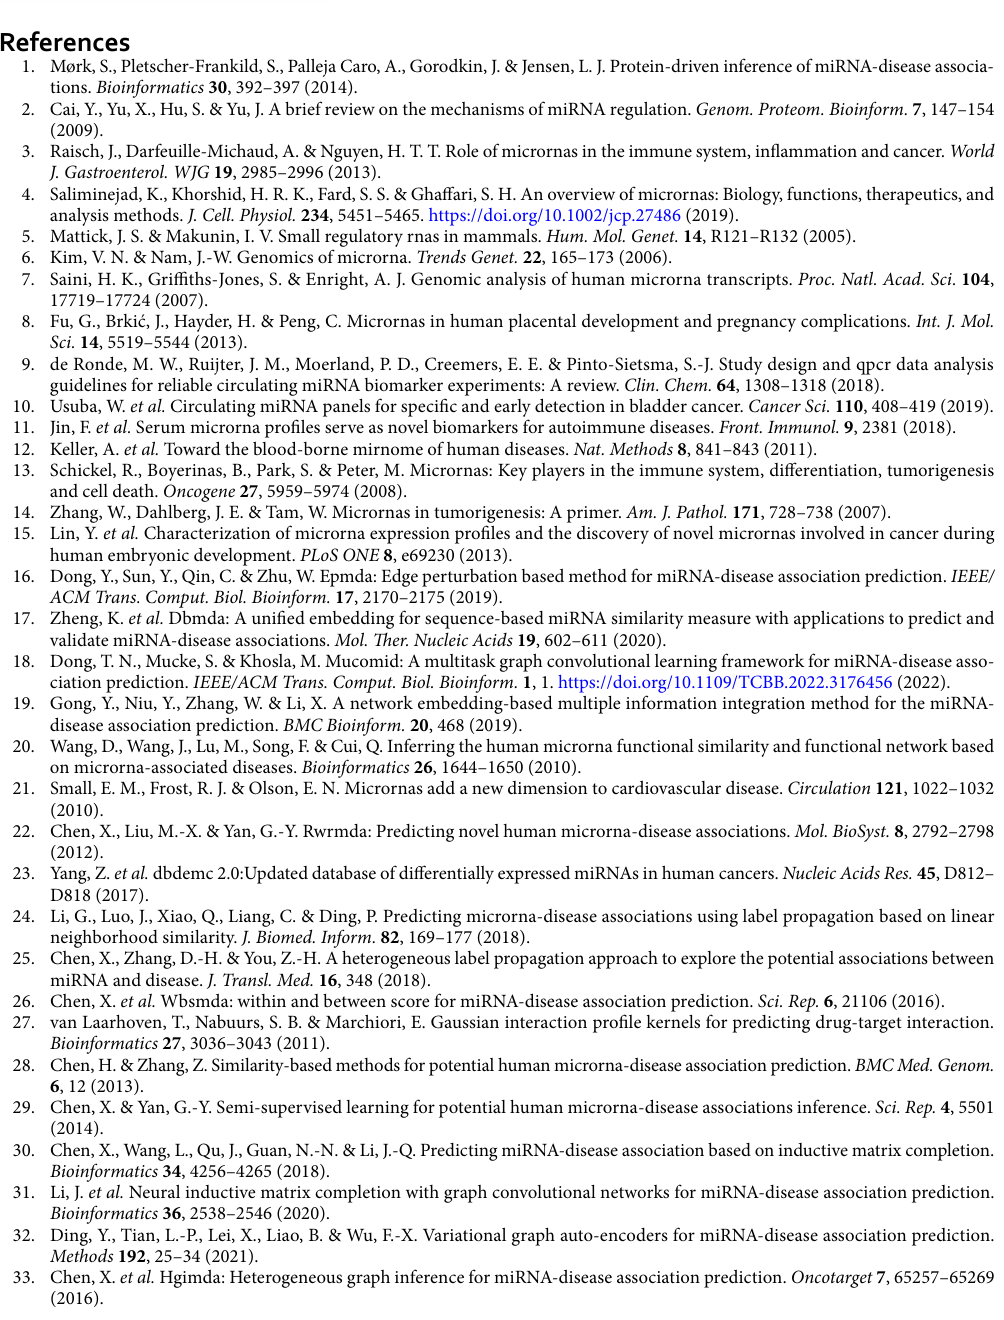
Figure 6. The final miRNA-disease input pair